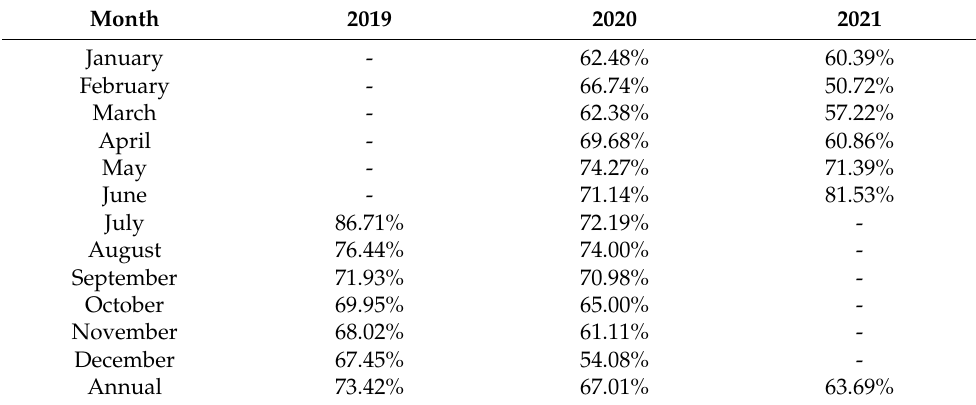
Table 6. Performance ratio